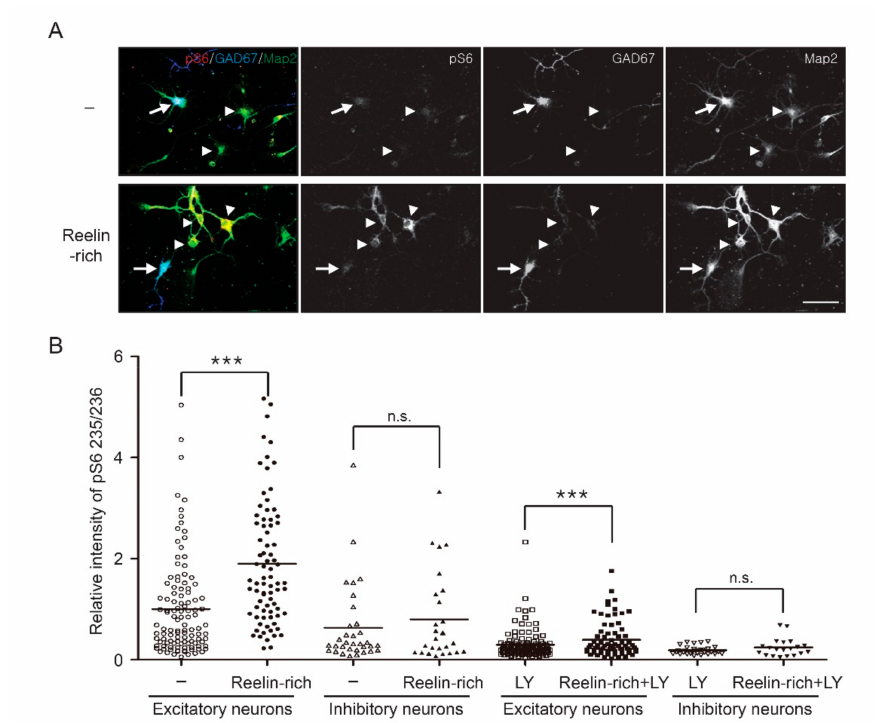
Figure 2. Phosphorylation status of ribosomal S6 protein, a downstream molecule of the PI3K/Akt pathway, by Reelin-rich protein supplementation in individual inhibitory neurons: ( A ) Five-day in vitro hippocampal neurons were supplemented with Reelin-rich protein for 20 min and imaged using confocal microscopy using Map2, GAD67, or phospho-S6 (serine 235/236) antibodies. GAD67- positive inhibitory neurons are indicated with arrows and GAD67-negative excitatory neurons with arrowheads. ( B ) The fluorescence intensity of the soma was quantified and the sample distribution of individual neurons is shown (number of excitatory neurons = 75–119, number of inhibitory neurons = 20–33). A significant increase in the levels of phosphorylated S6 was shown in GAD67- negative–Map2-positive excitatory neurons, but not in GAD67-positive inhibitory neurons. S6 phosphorylation in both excitatory and inhibitory neurons was completely suppressed under the PI3K inhibitor LY294002 (10 µ M), regardless of Reelin-rich protein supplementation. The results were analyzed using the Kruskal–Wallis test followed by Dunn’s comparison test. Note: *** p < 0.001; n.s., nonsignificant. Scale bar, 50 µ